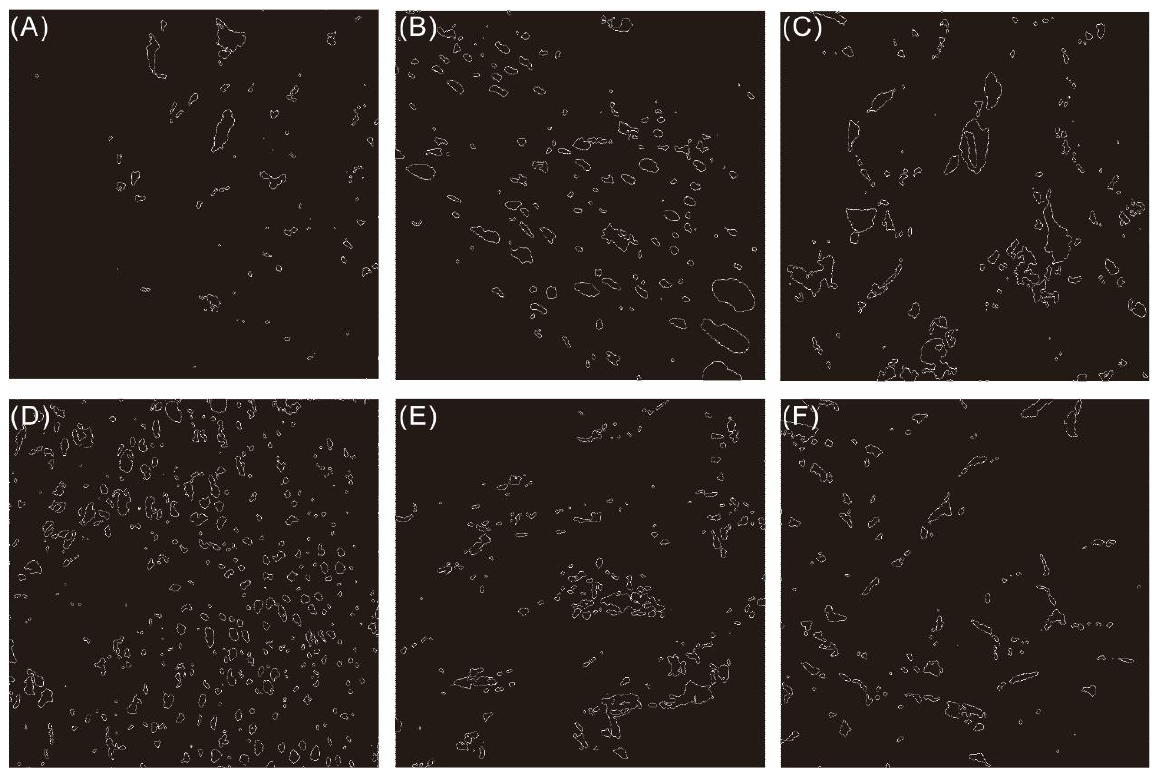
Figure 9. The average specific surface area of threshold image in Figure 2A – F corresponding to ( A – F ).